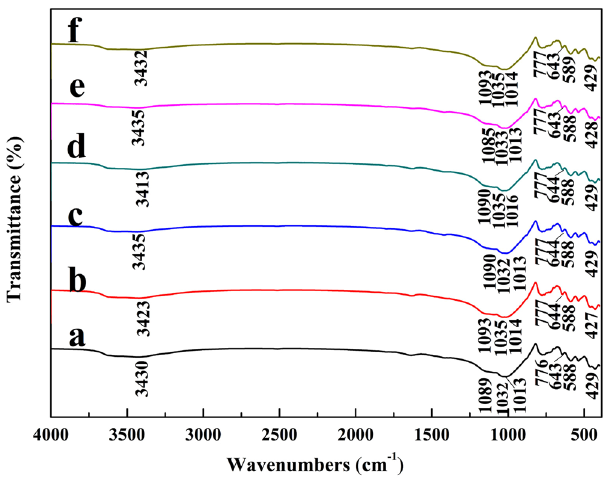
Figure 2. FTIR spectra of ( a ) RMF ( b ) MMF-H2.5 ( c ) MMF-OH3.0 ( d ) MMF-La5.0 ( e ) CMMF-400 and ( f )